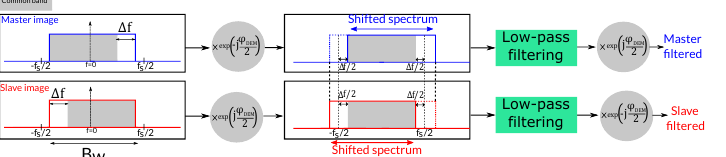
Figure 3. Common band alignment of two images’ spectra using demodulation with a topographic phase, followed bylow − pass filtering.